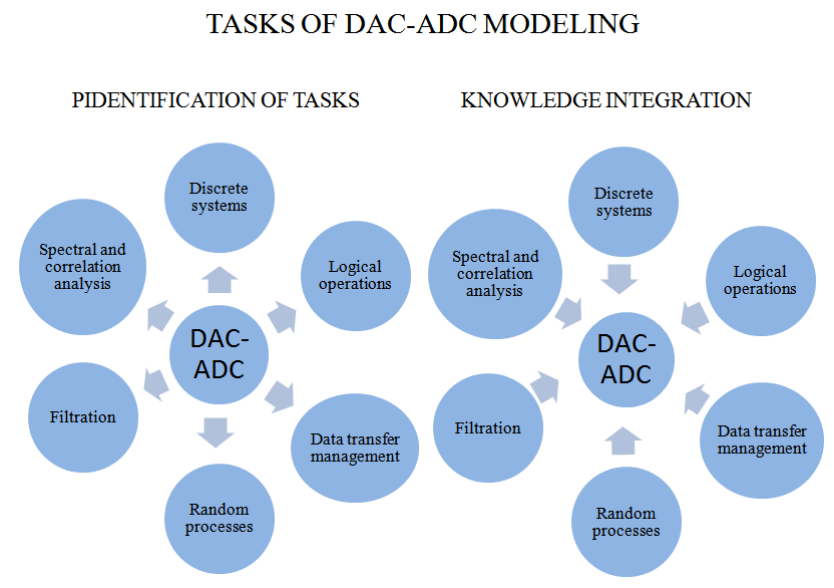
Fig. 5. Application of computer modeling technologies as part of the development of DAC-ADC.